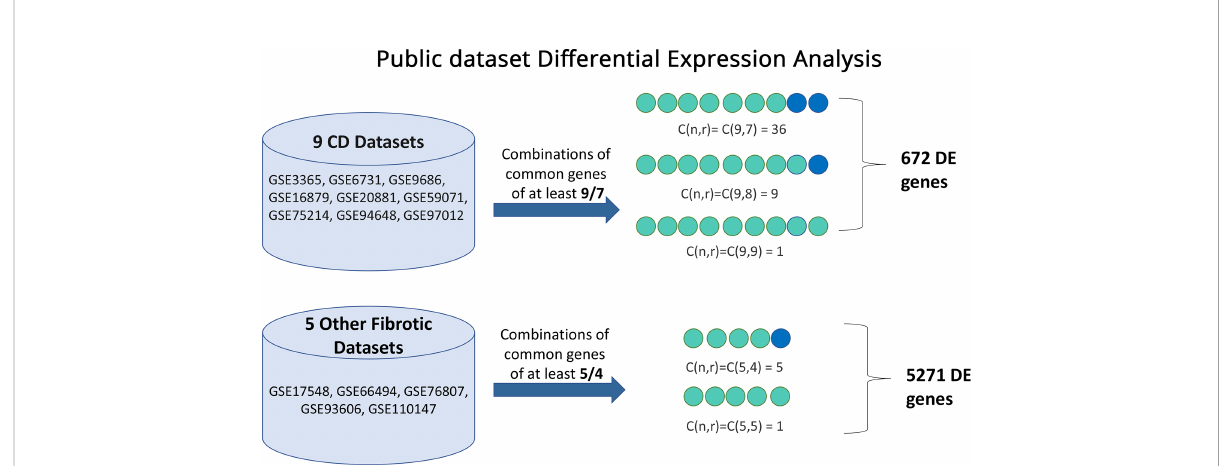
FIGURE 1 Visual representation of the differential expression analysis pipeline employed to identify fi brosis-related genes from public datasets of 5 fi brotic disorders (Crohn ’ s Disease, Idiopathic Pulmonary Fibrosis, Chronic Kidney Disease, Systemic Sclerosis and Chronic Liver Disease) using the GEO2R online tool. In total, 46 combinations of the Crohn ’ s Disease datasets yielded 672 differentially expressed genes and 6 combinations of the datasets from other fi brotic disorder highlighted 5271 differentially expressed genes. Multiset comparisons of combinations were conducted using the SuperExactTest R